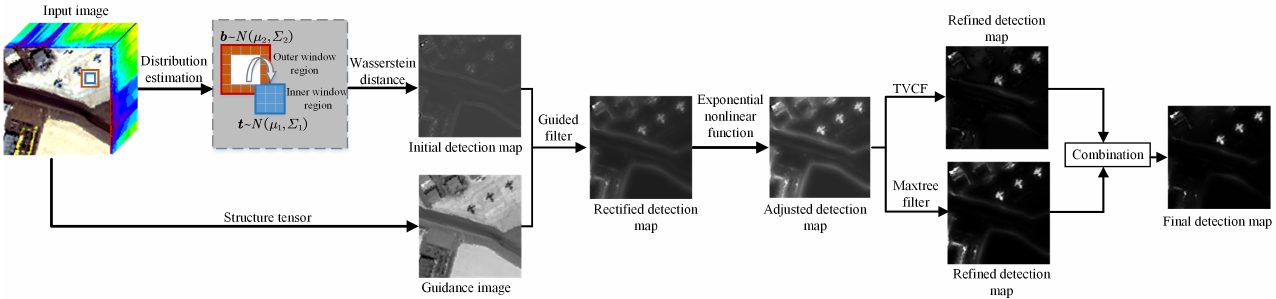
Figure 1. Schematic of the hyperspectral AD algorithm based on Wassertein distance and spatial